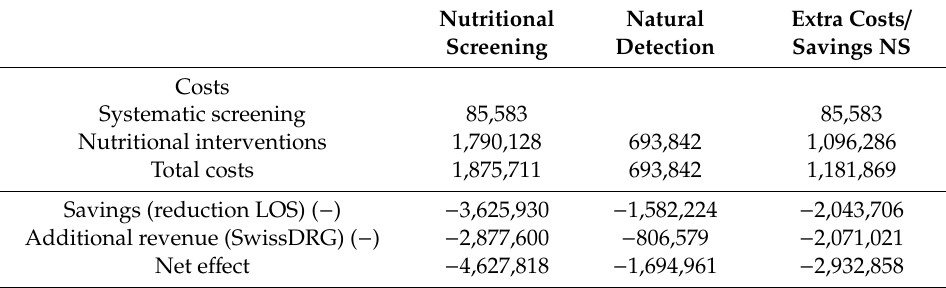
Table 5. Net monetary e ff ects of the introduction of a systematic NS. Nutritional